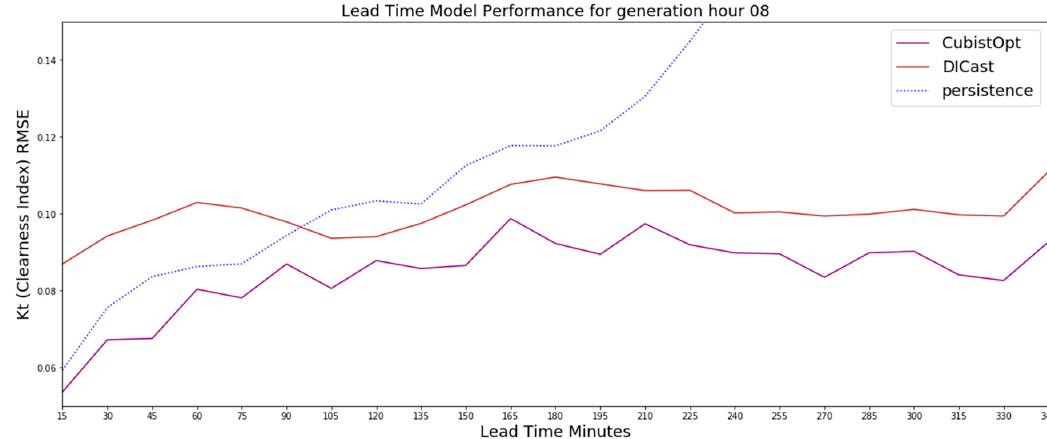
Figure A4. The 8 UTC generation time RMSE results on the test dataset for the CubistOpt method, the clearness index persistence and the DICast forecasts, which show that the CubistOpt (purple line) method has the lowest error over all time